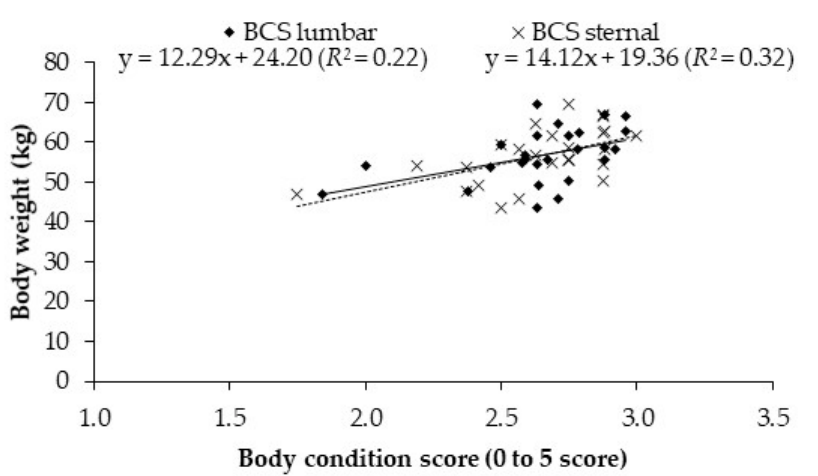
Figure 2. Relationship between lumbar or sternal body condition score (BCS, scale 0–5) and body weight in lactating Saanen goats. Table 3. Regression equations (y = a + bx), coefficient of determination ( R 2 ), and residual standard deviation (RSD) values for estimate of the different fat depot weights (kg) and the total weight of all fat combined (y variables) based on the pre-slaughter measurement values lumbar, sternal, and perirenal fat thickness depths measured by ultrasound (FTUSl, FTUSs, and FTUSpr, respectively) (x